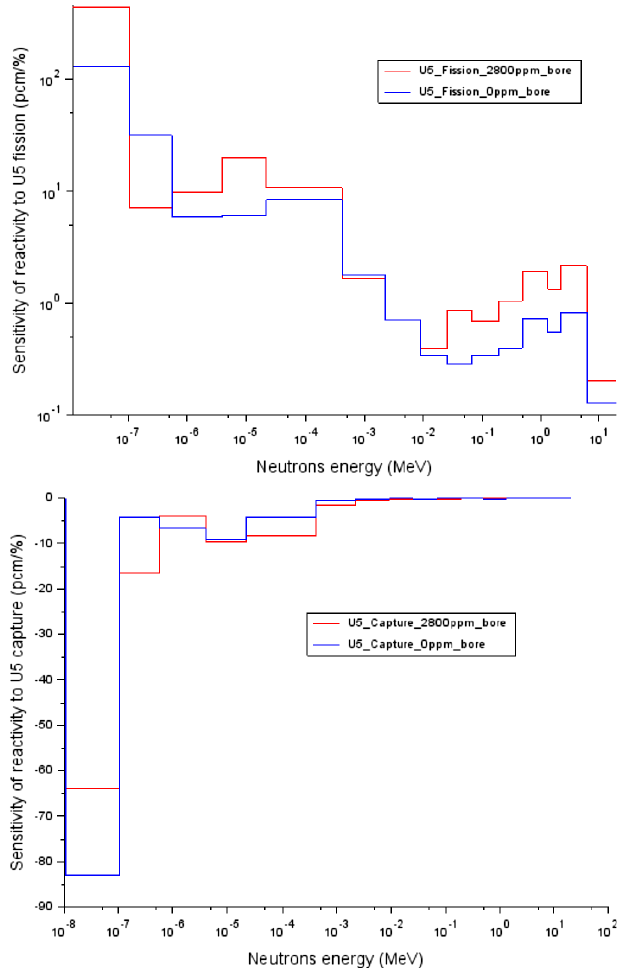
Fig. 3. Sensitivity pro fi les of reactivity for U5 fi ssion capture at 0 and 2800 ppm of bore (15